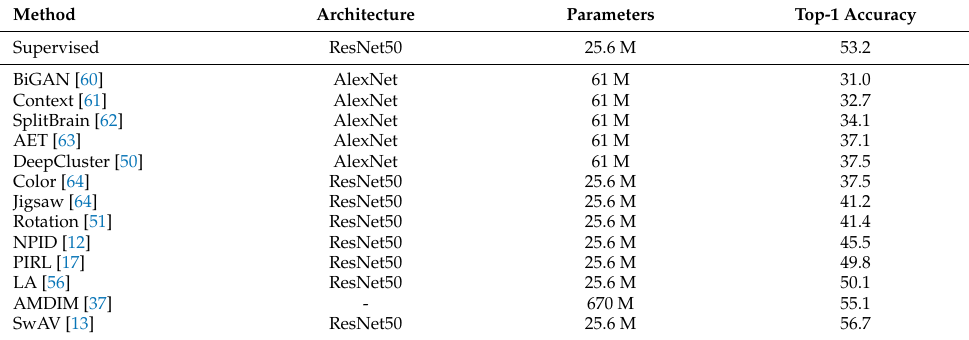
Table 2. Image classification accuracy on Places dataset pretrained on ImageNet.